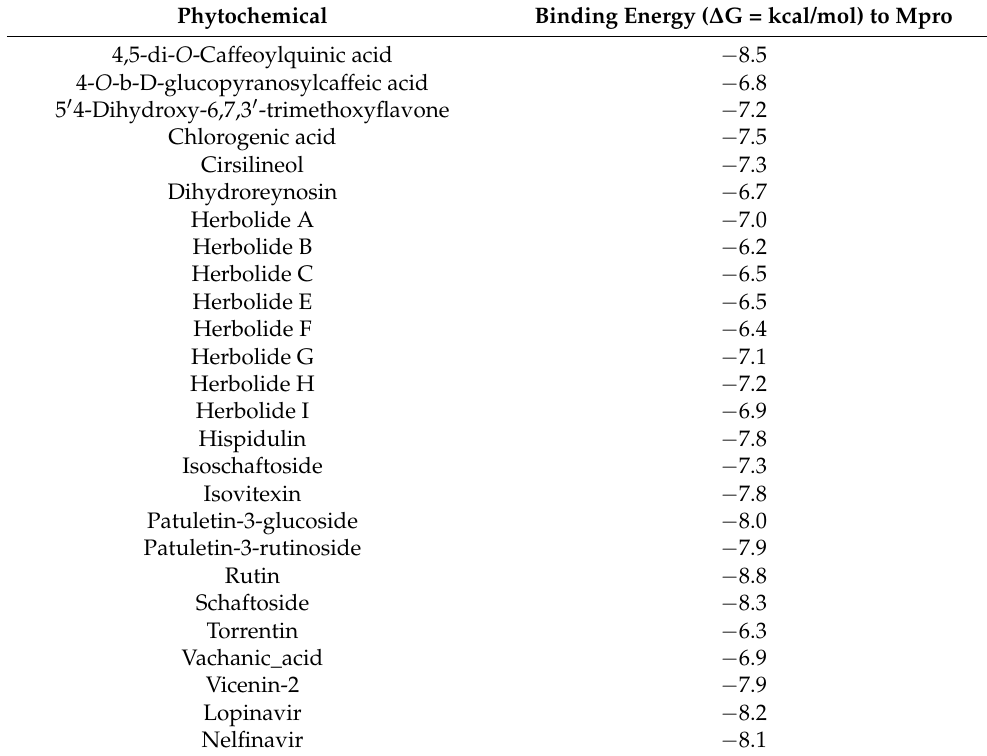
Table 1. Predicted binding energy in molecular docking studies of some Artemisia herba-alba phyto- chemicals to Mpro of SARS-CoV-2. Phytochemical Binding Energy ( ∆ G = kcal/mol) to Mpro 4,5-di- O -Caffeoylquinic acid − 8.5 4- O -b-D-glucopyranosylcaffeic acid − 6.8 5 (cid:48) 4-Dihydroxy-6,7,3 (cid:48) -trimethoxyflavone − 7.2 Chlorogenic acid − 7.5 Cirsilineol − 7.3 Dihydroreynosin − 6.7 Herbolide A − 7.0 Herbolide B − 6.2 Herbolide C − 6.5 Herbolide E − 6.5 Herbolide F − 6.4 Herbolide G − 7.1 Herbolide H − 7.2 Herbolide I − 6.9 Hispidulin − 7.8 Isoschaftoside − 7.3 Isovitexin − 7.8 Patuletin-3-glucoside − 8.0 Patuletin-3-rutinoside − 7.9 Rutin − 8.8 Schaftoside − 8.3 Torrentin − 6.3 Vachanic_acid − 6.9 Vicenin-2 − 7.9 Lopinavir − 8.2 Nelfinavir −